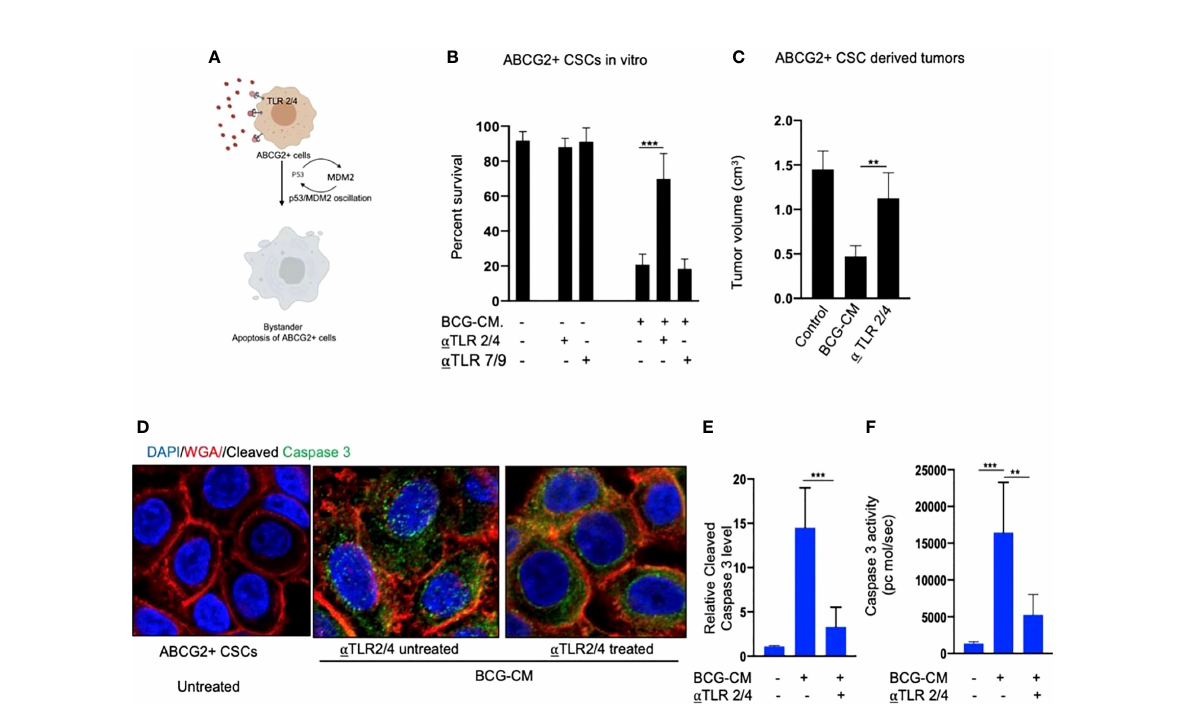
FIGURE 7 Bystander apoptosis is mediated by TLR2 and TLR4. (A) Hypothesis: TLR2/4 are required for the execution of HMGB1/p53 complex – mediated bystander apoptosis. (B) Relative cell viability of BCG-CM – treated (72 h) EpCAM+/ABCG2+ CSCs pretreated with TLR-neutralizing antibodies. (C) SCC-25 xenograft size in BCG-CM – treated and TLR-neutralizing Abs pretreated mice (n=5). (D) Immuno fl uorescence labeling of BCG-CM – treated (72 h) EpCAM+/ABCG2+ CSCs with cleaved caspase-3 (Dapi, nuclear stain; WGA, cell membrane stain). Magni fi cation, 20×. (E, F)